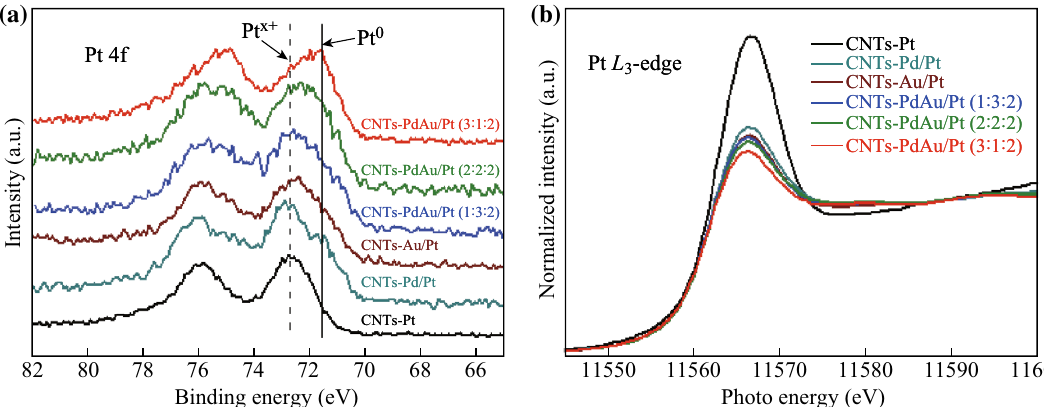
Fig. 6 a Pt 4 f XPS spectra and b Pt L 3 -edge XANES spectra of CNTs-supported PdAu/Pt trimetallic NPs with different Pd/Au/Pt ratios, Au/Pt and Pd/Pt bimetallic NPs, and Pt